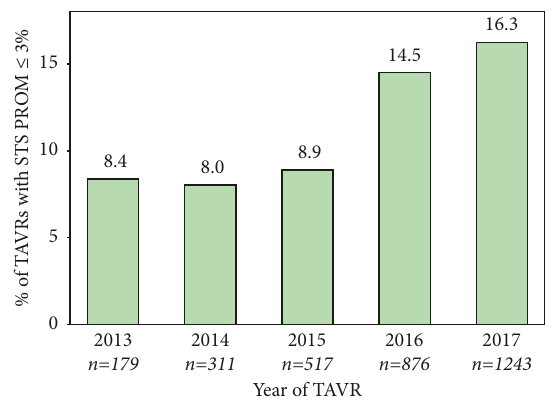
Figure 2: Percentage of transcatheter aortic valve replacement procedures performed in patients with STS PROM centage of overall transcatheter aortic valve replacement (TAVR) procedures that were performed in patients with STS PROM by year of procedure is